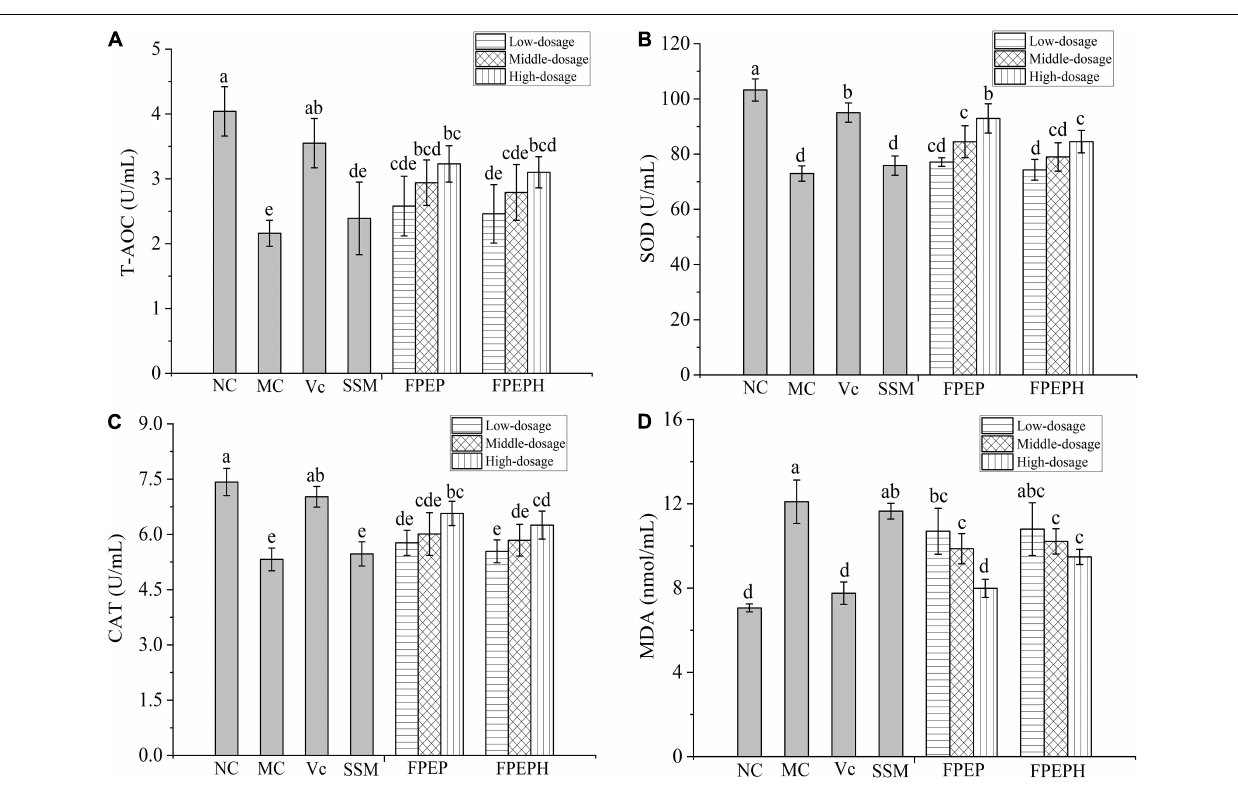
Figure 7 . In Figures 7A–C , the observed species index,